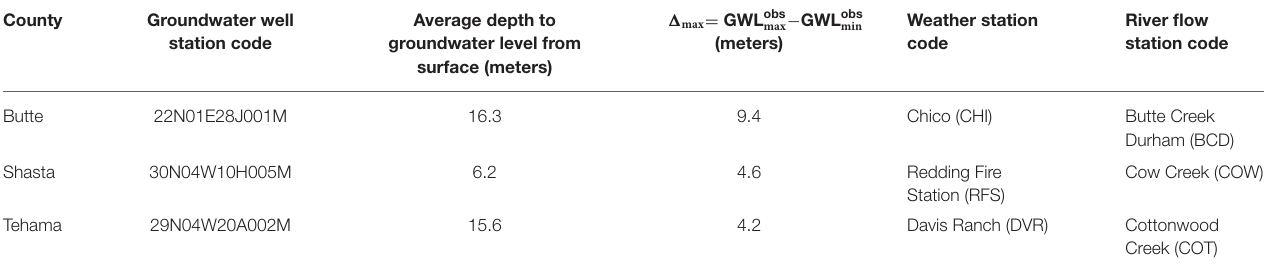
TABLE 1 | Data sources of historical observations.